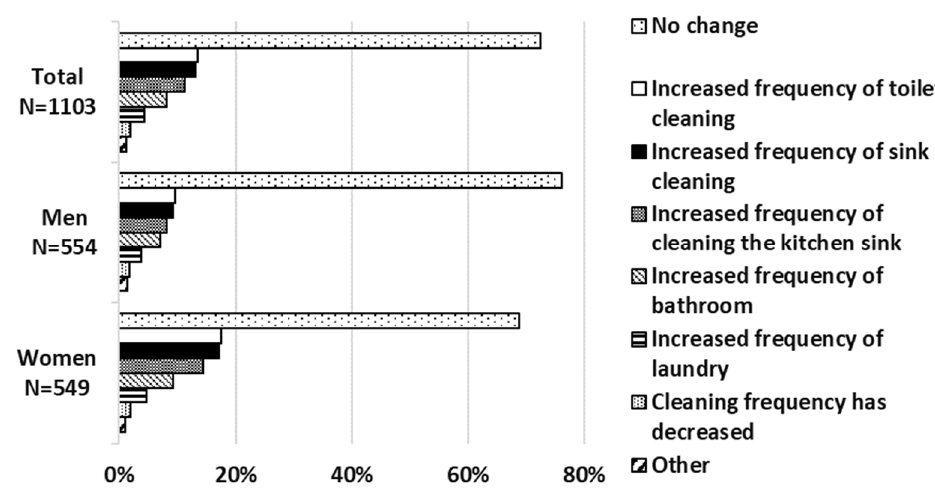
Figure 13. Changes in the frequency of cleaning for water use facilities (multiple